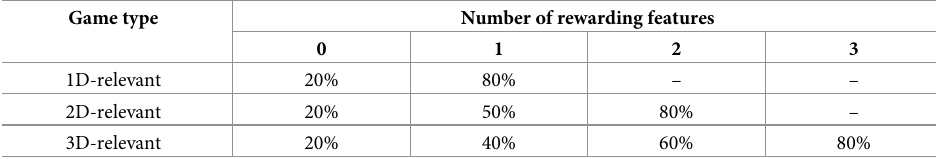
Table 1. The reward probability of a stimulus in each game type (1D, 2D, and 3D-relevant games) was determined by the number of rewarding features in the stimulus. Each row corresponds to one game type. Across all game types, the reward probabilities were 20% if the stimulus contained no rewarding features, 80% if it contained all rewarding features, and linear interpolations between 20% and 80% if it contained a subset of rewarding features. For example, in a 3D-relevant game, if the stimulus contained two of the three rewarding features, the reward probability for that trial would be 60%. These probabilities guarantee that a participant who performs randomly would have 40% probability of obtaining a reward across all game types. This can be seen by calculating, for each game type, the chance of randomly choosing a certain number of rewarding features, multiplied by the corresponding reward probability. Equal chance probability across game types ensured that chance behavior would not be informative about the number of relevant dimensions in unknown